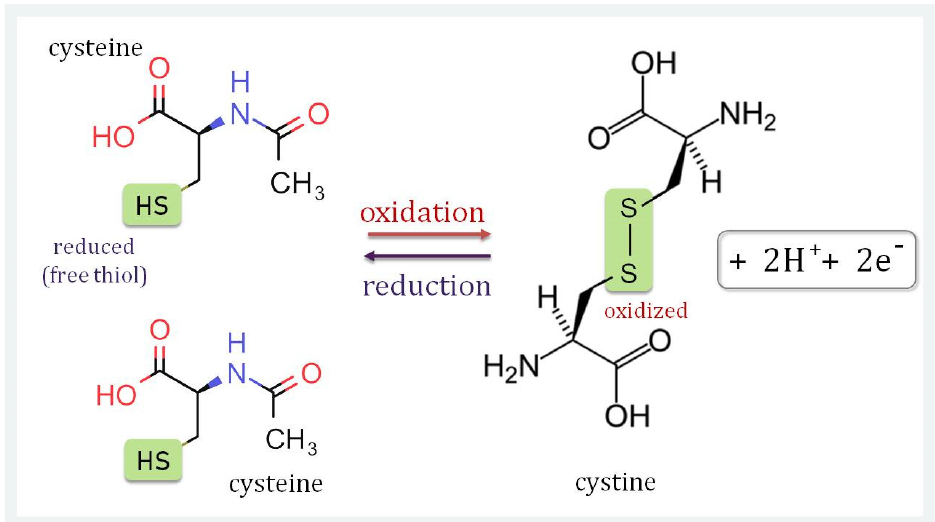
Figure 1. Disulfide bridge formation in cystine. A disulfide bridge can form between two sulfur atoms (-S-S-) of two identical or different thiol compounds. Substances containing such bridges are called disulfides. In proteins, disulfide bonds are formed between the sulfur atoms of two cysteinyl residues yielding cystine. Disulfides stabilize the tertiary structure of proteins. This covalent structural feature is the strongest force in protein structure formation and complements ionic salt bridges, hydrogen bonds and van der Waals forces.